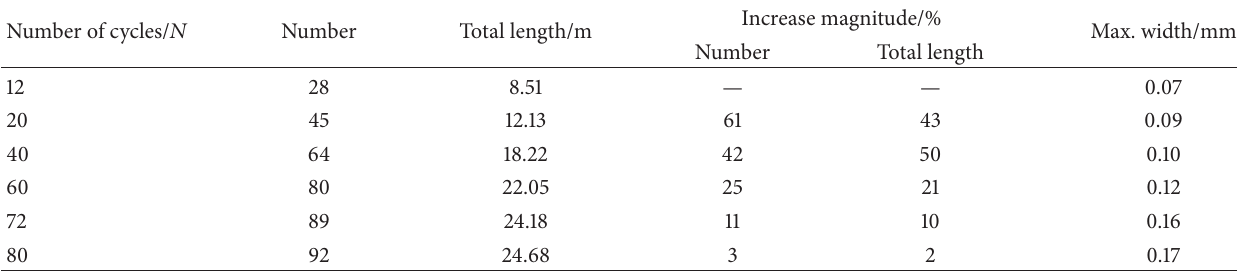
Table 4: Number, length, and increase magnitude of